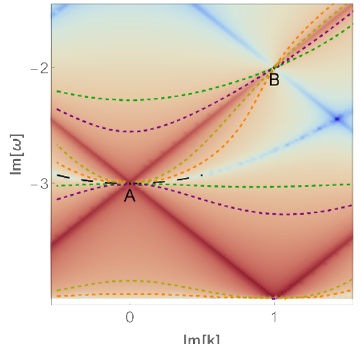
Figure 5 . Zoom-in of figure 2(b) including a type-I point (B) and a type-II point (A). The dotted lines represent curves on which the Green’s function has a constant value. Different colors represent different values: { black , orange , yellow , green , purple } = { 0 , 1 . 05 , 3 , − 1 . 05 , − 3 }